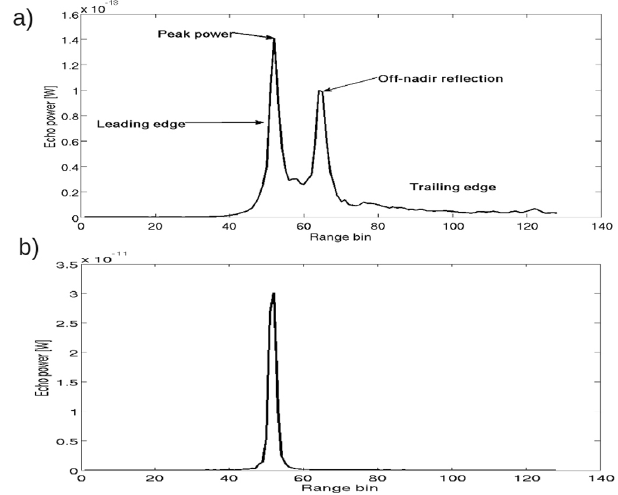
Figure 1. Example CryoSat-2 waveforms. (a) Example waveform for a sea ice floe. The waveform contains an off-nadir reflection from a surface with high backscatter which results in a secondary peak. (b) Example specular waveform from a